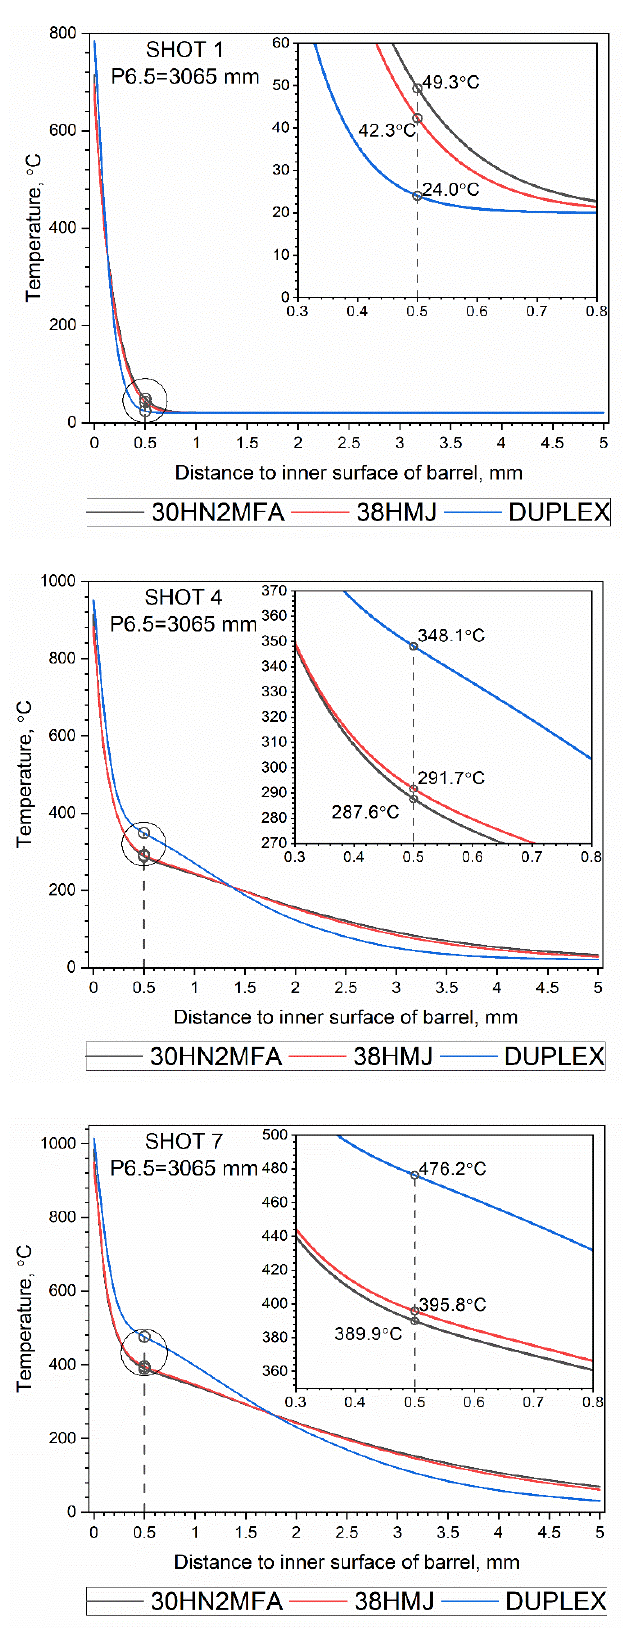
Figure 11. Temperature distributions T i ( t , r , z ) along the barrel thickness for selected steels for the first, fourth and seventh shots. The sign: P6.5—in the middle of the S6 zone.